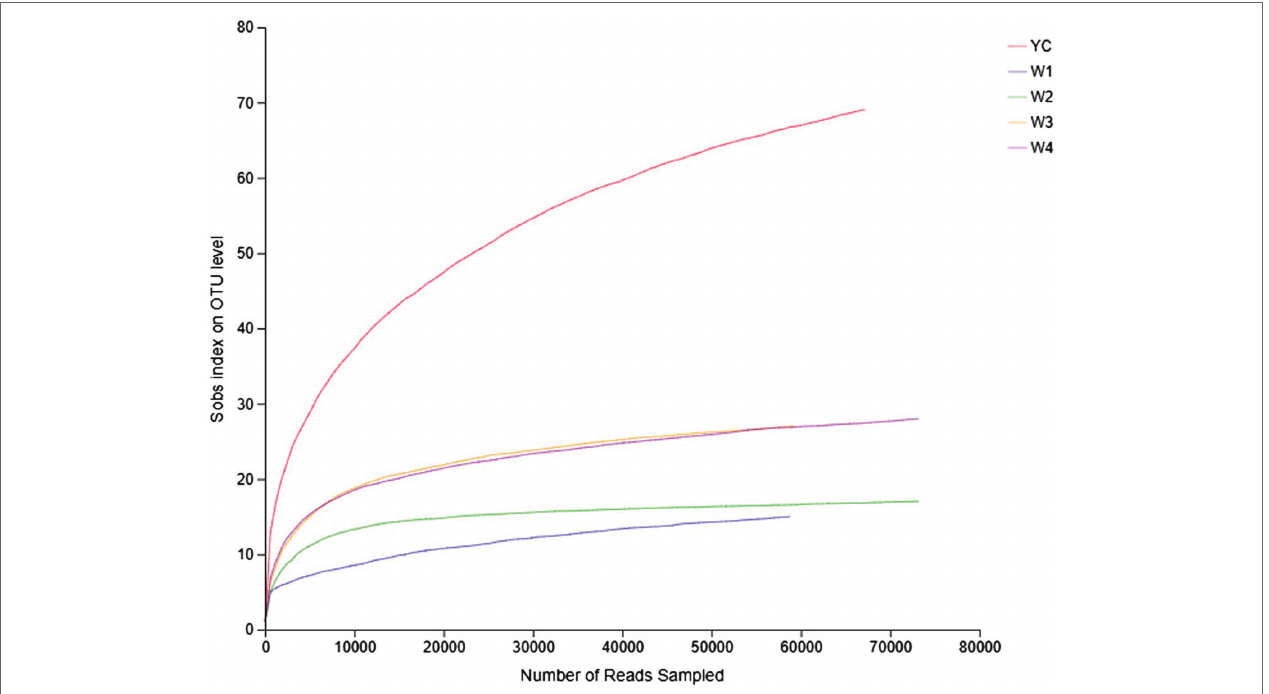
FIGURE 1 | Rank abundance curves of all the samples. The abscissa represents the rank of the number of operational taxonomic units (OTUs) at a certain taxonomic level, and the ordinate represents the relative percentage of the number of species at that classification level. The position of the abscissa of the extension end point of the sample curve is the number of species in each sample. A smooth decline indicates higher species diversity in all the samples, while a rapid and steep decline indicates a high proportion of the major bacterial strains and low diversity.